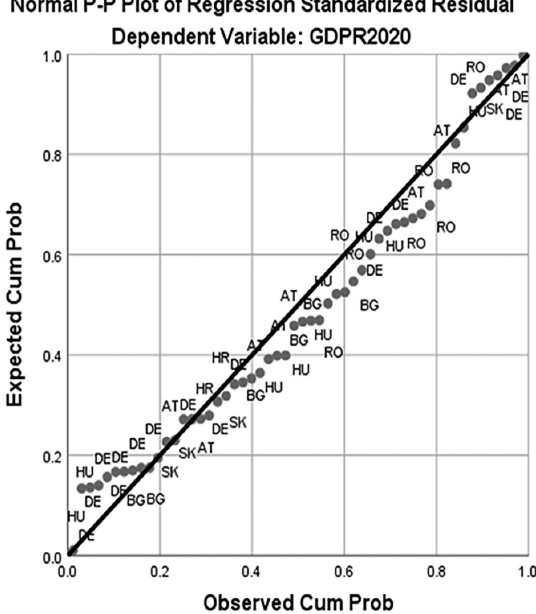
Figure 9. P-P Plot for sustainable development of the EUSDR in 2020 Table 14. ANOVA test for the model in 2020 Model Sum of Squares df Mean Square F Sig. Regression 97182.736 5 19436.547